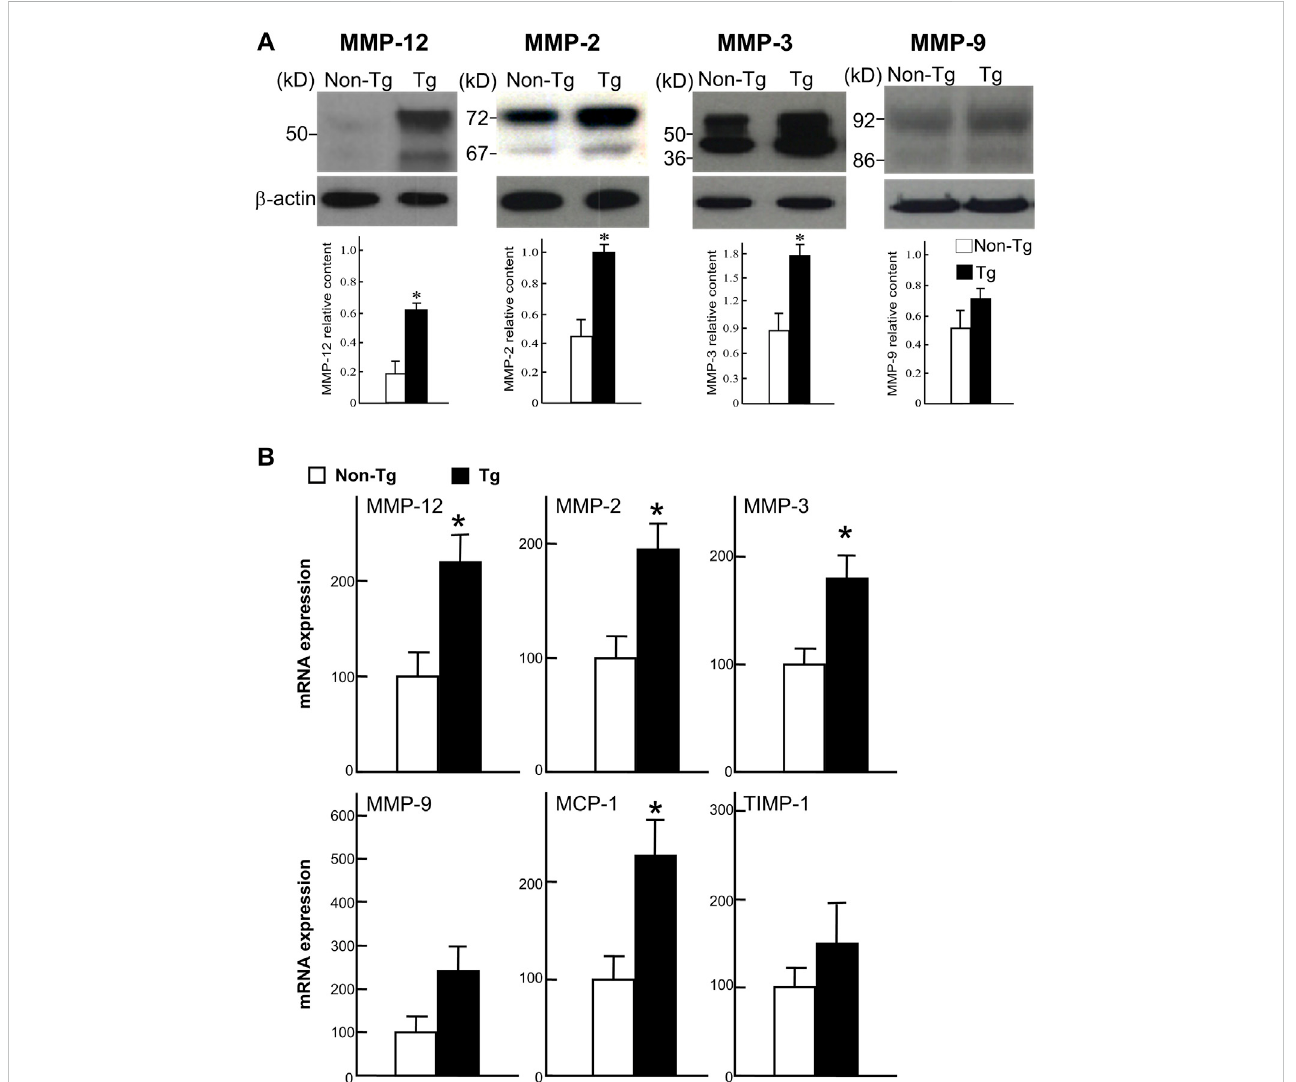
FIGURE 6 Westernblotanalysis (A) andreal-timeRT-PCRanalysis (B) .A:Proteinsisolatedfromtheaorticlesionsweresubjectedto10%SDS-PAGEunderreducing conditions,andprobedwithAbsagainstMMP-12,MMP-2,MMP-3,andMMP-9.Thesamemembranewasre-probedwithmAbagainst β -actintoindicatethat equalamountsofproteinswereloaded.TherelativelevelofeachMMPwasquantitatedbycalculatingtheopticaldensity(OD)ofeachsignalonthe fi lmsusing a densitometer (GS-700, Bio-Rad) and normalized relative to the amount of protein for β -actin. All analyses were performed in triplicate and the values are expressed as the mean ± SE ( n = 3 for each group). * p < .05 vs. non-Tg. B: Expression of MMP-12, -2, -3, and -9, MCP-1, and TIMP-1 were analyzed with real-time RT-PCR. Expression levels of each gene are expressed as a percentage of the control value. Data are expressed as the mean ± SE ( n = 5 for each group). * p < .05 vs.